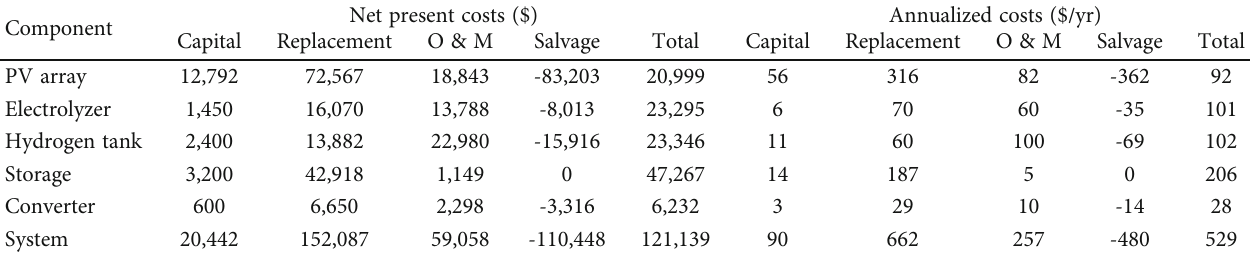
Table 11: Present worth and annualized value of all costs over 40 years.